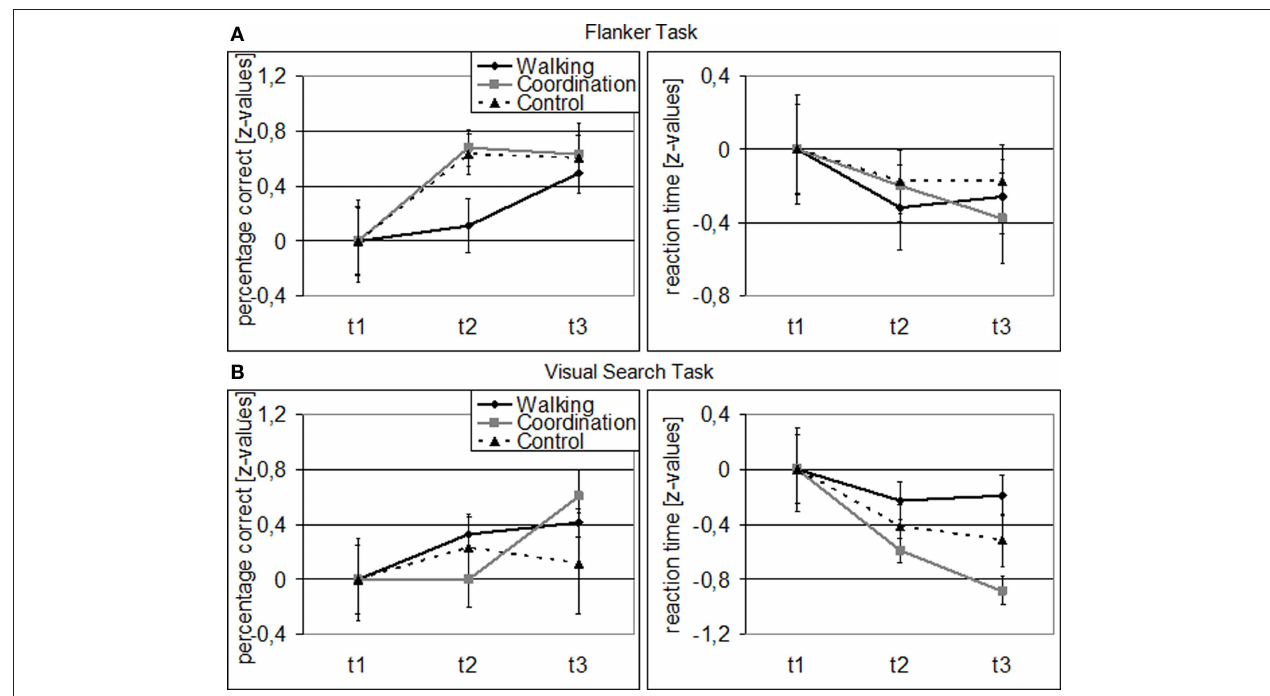
FIguRe 1 | Behavioral data for Flanker (A) and Visual Search Task (B): Z -transformed for cardiovascular training (walking), coordination training (coordination), and control group (relaxation and stretching) separately (related to t 1). Note: Error bars represent